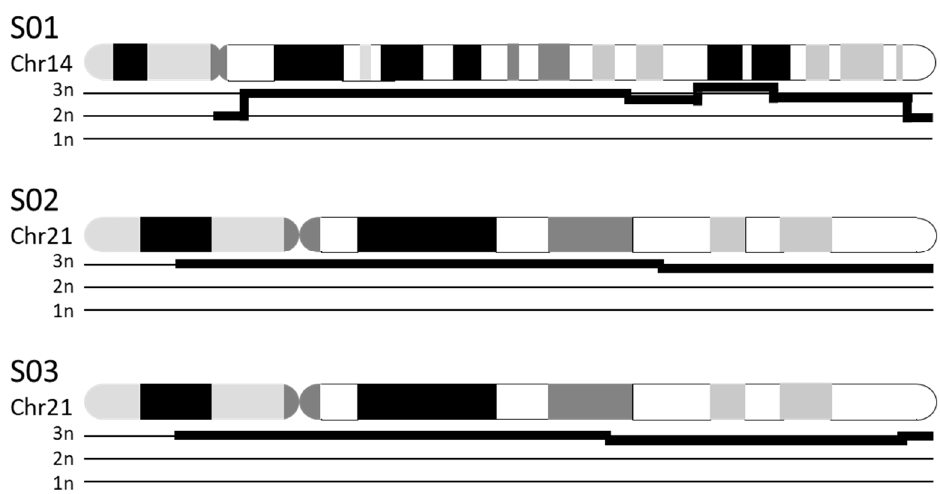
Figure 1. Schematic representation of Optical Genome Mapping (OGM) data to visualize trisomies. Free trisomies such as the depicted trisomies 14 (S01) and 21 (S02, S03) are detected by quantification of uniquely attributable genomic material, similar to the data obtained by aCGH. The graphs (bold black lines) underneath the ideograms (G-banding, black and gray: Giemsa positive, white: Giemsa negative) show the relative quantity of genetic material from chromosomes 14 and 21. In all three cases, the graphs show an elevated quantity of DNA, equaling three copies of each depicted chromosome. Centromeric regions and nonunique segments of the p ‐ arms cannot be quantified, even though the continuous graphs suggest otherwise.